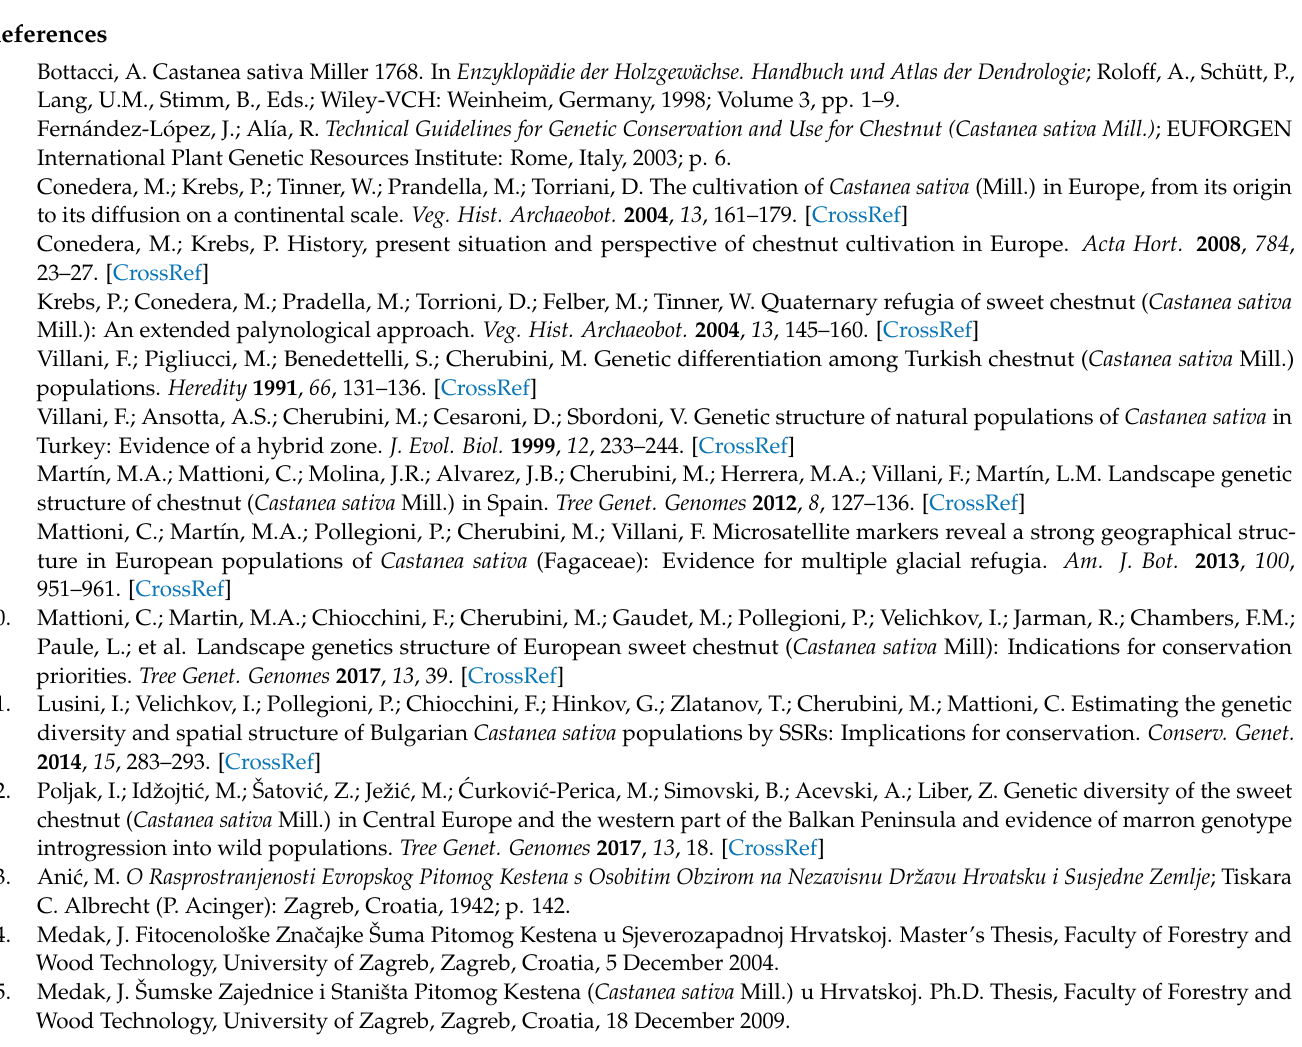
Table S3. Results of the stepwise discriminant analyses for morphometric traits. Table S4. Results of the stepwise discriminant analyses for chemical